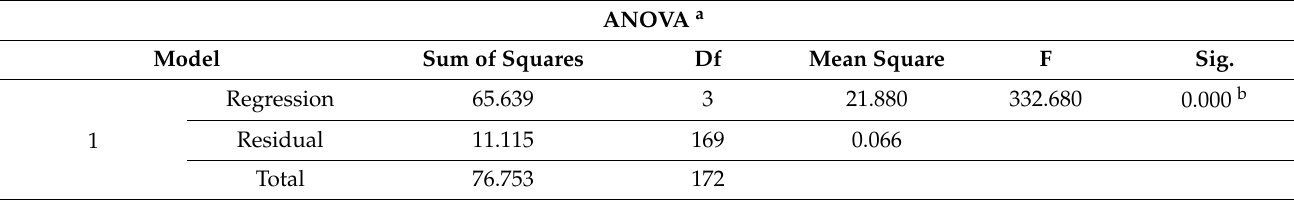
Table 10. Test for model